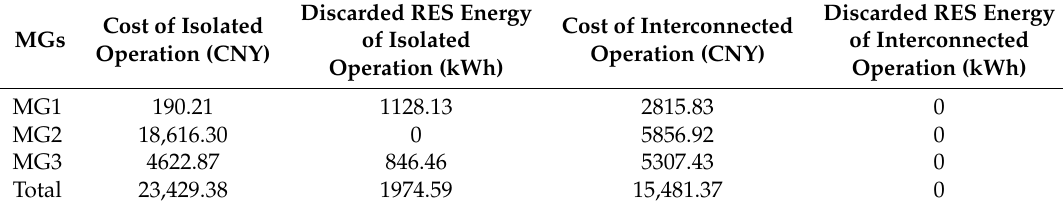
Cost and discarded renewable energy resources (RES) energy in isolated and interconnected